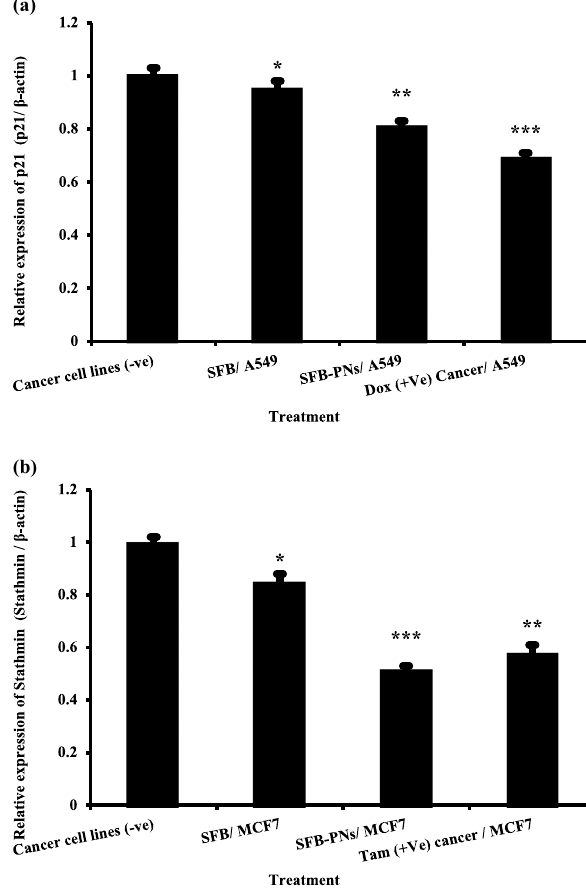
Figure 5: ( a ) The expression of p21 gene in lung cancer cell lines treated with SFB, SFB - NPs, and DOX. Expression levels were stan - dardized using the expression of the housekeeping gene β - actin . Data are presented as mean ± SEM. Mean values within tissue with unlike superscript letters were signi fi cantly di ff erent ( p < 0.05 ) . ( b ) The expression of Stathmin - 1 gene in breast cancer cell lines treated with SFB, SFB - NPs, and Tam. Expression levels were standardized using the expression of the housekeeping gene β - actin . Data are presented as mean ± SEM. Mean values within tissue with unlike superscript letters were signi fi cantly di ff erent ( P < 0.05 ) . * p ≤ 0.05, ** p ≤ 0.01, or *** p ≤ 0.001 denote statistically signi fi cant di ff er - ences compared to control